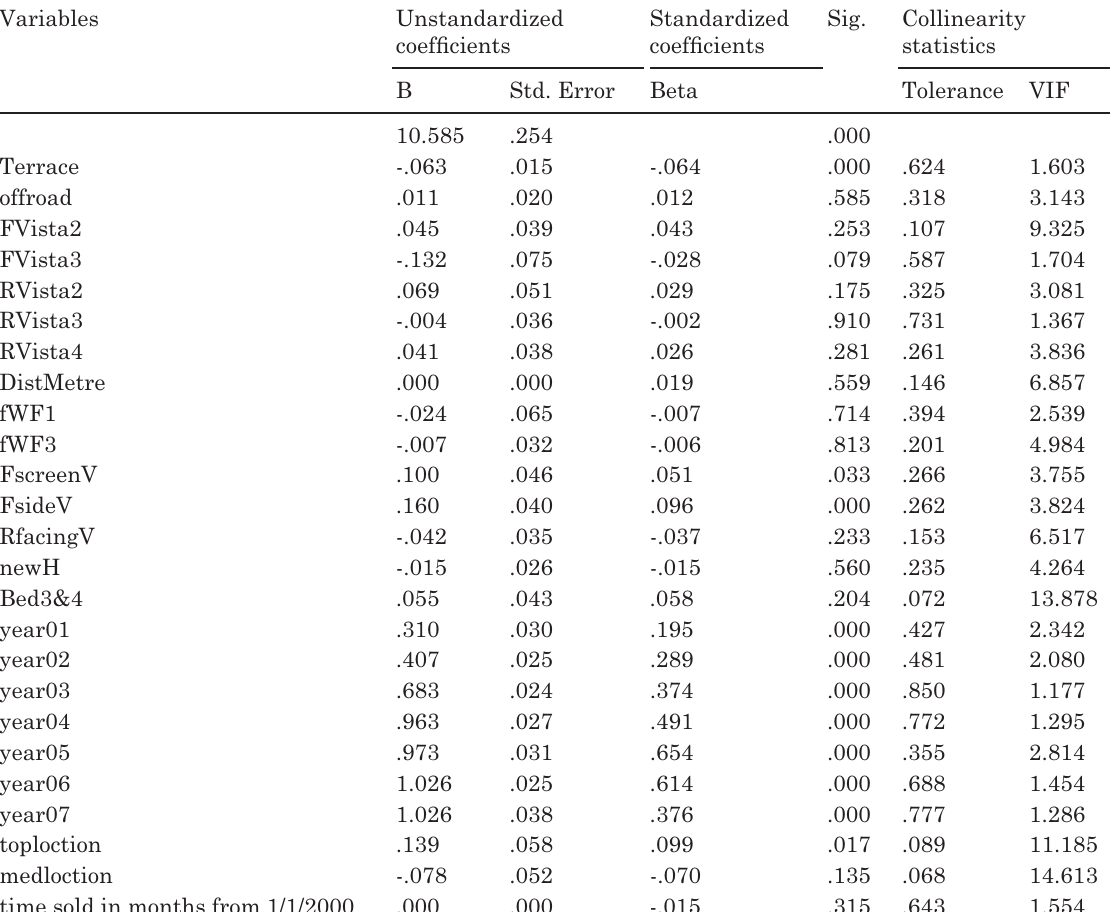
Table 5. Regression Model - including all independent variables Variables